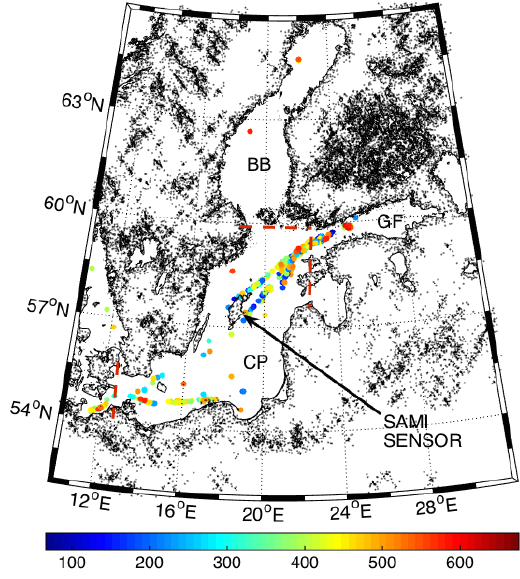
Figure 1. The dashed red lines divide the Baltic Sea into three basins: CP: central part; BB: Gulf of Bothnia; and GF: Gulf of Fin- land. Monthly data are available from 1998 to 2011 for the Baltic Sea. The colour bar shows the p CO 2 values in µatm. The black ar- row shows the position of the SAMI